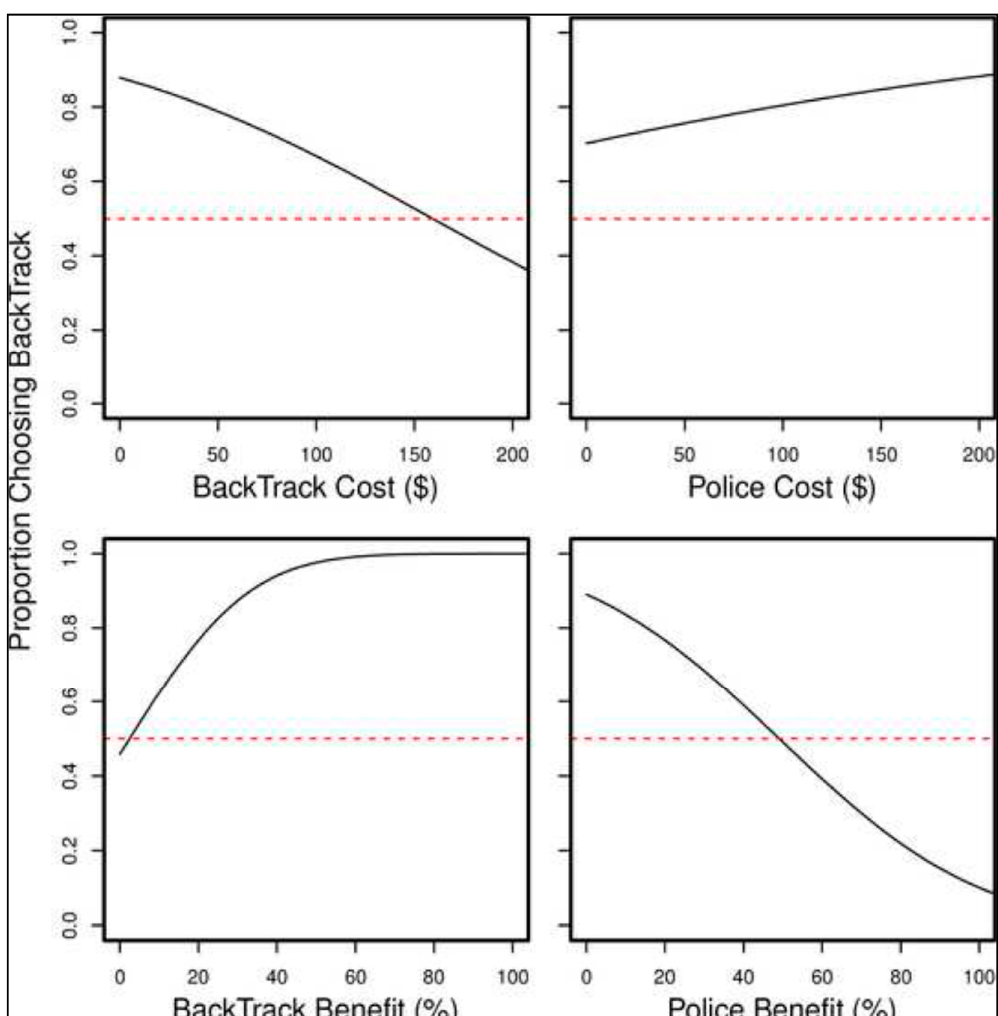
Figure 1. Proportion of sample choosing BackTrack.